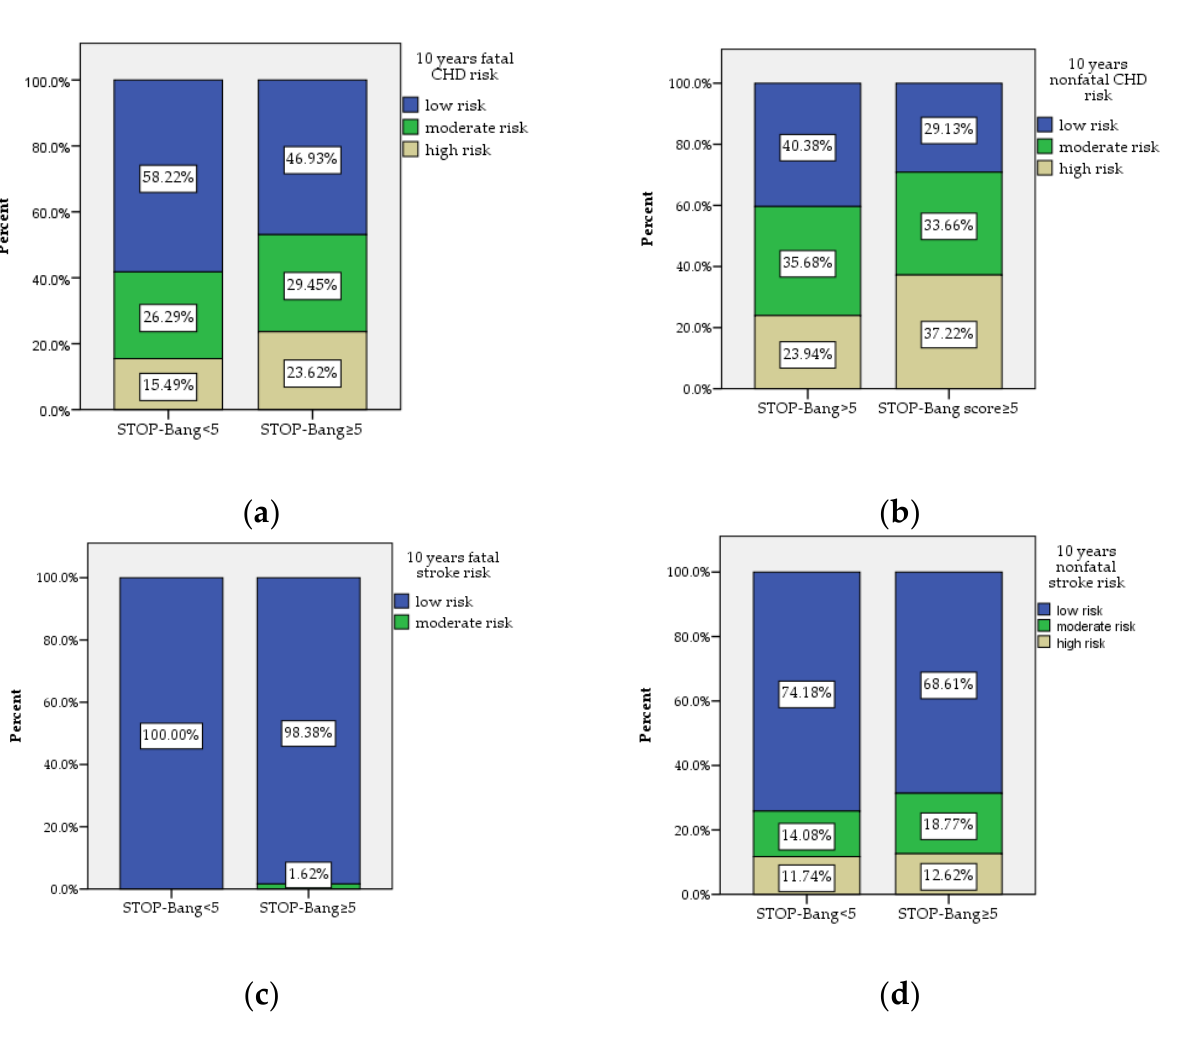
Figure 2. The frequency of 10-year cardiovascular risk calculated using the UKPDS risk engine evidencing that ( a ) patients with T2DM and STOP-Bang scores ≥5 are at statistically significant higher risk of developing fatal CHD ( p = 0.022); ( b ) patients with T2DM and STOP-Bang scores ≥5 are at statistically significant higher risk of developing nonfatal CHD ( p = 0.003); ( c ) there was no statistically significant difference between the two study groups regarding fatal stroke; ( d ) no statistically significant differences were found between the two study